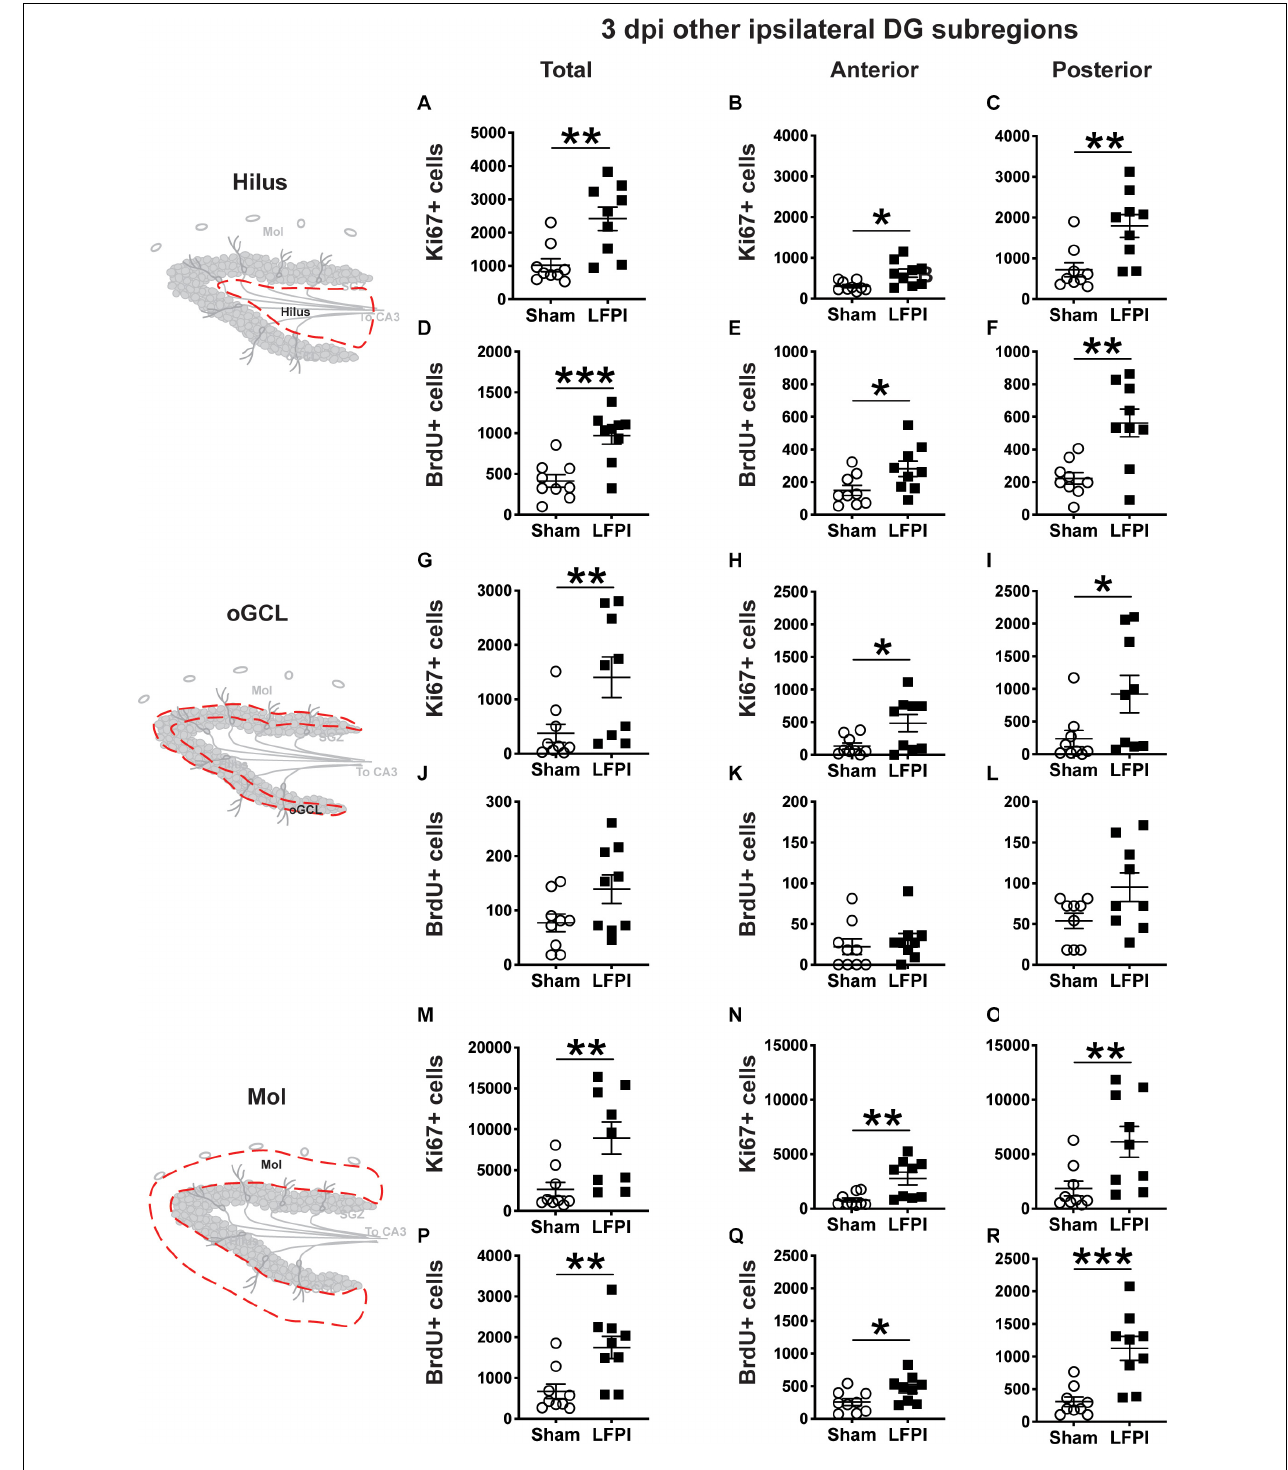
FIGURE 3 | Relative to Sham, LFPI increases the number of Ki67+ and BrdU+ proliferating cells in the ipsilateral DG hilus and molecular layer (Mol) 3 dpi. Stereological quantification of Ki67+ (A–C, G–I, M–O ; Sham n = 9, LFPI n = 9) and BrdU+ (D–F, J–L, P–R ; Sham n = 9, LFPI n = 9) cells in the hilus ( A–F ; red dotted line region, top-left schematic), outer granule cell layer ( G–L ; red dotted line region, middle-left schematic), and molecular layer ( M–R ; red dotted line region, bottom-left schematic). Immunopositive cells were quantified across the entire longitudinal axis (A,D,G,J,M,P) , and also broken up into anterior (B,E,H,K,N,Q) , and posterior (C,F,I,L,O,R) bins, operationally defined as Bregma levels − 0.92 to − 2.6; and − 2.6 to − 3.97, respectively. T-test, * p < 0.05, ** p < 0.01, and *** p < 0.001.